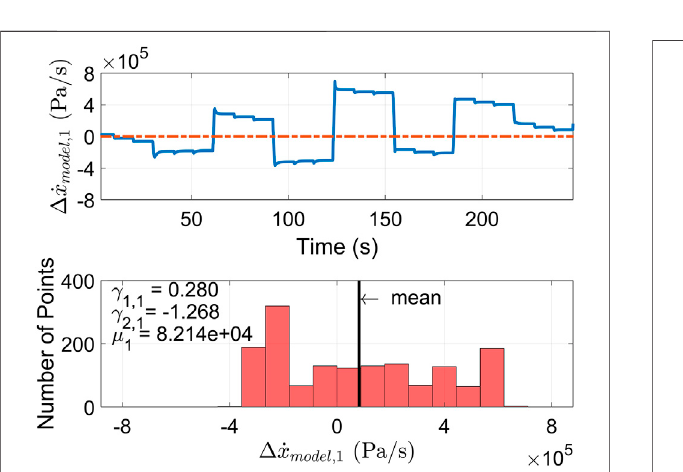
FIGURE 5 | Unknown disturbance estimation for boost manifold pressure: Δ _ x model , 1 .